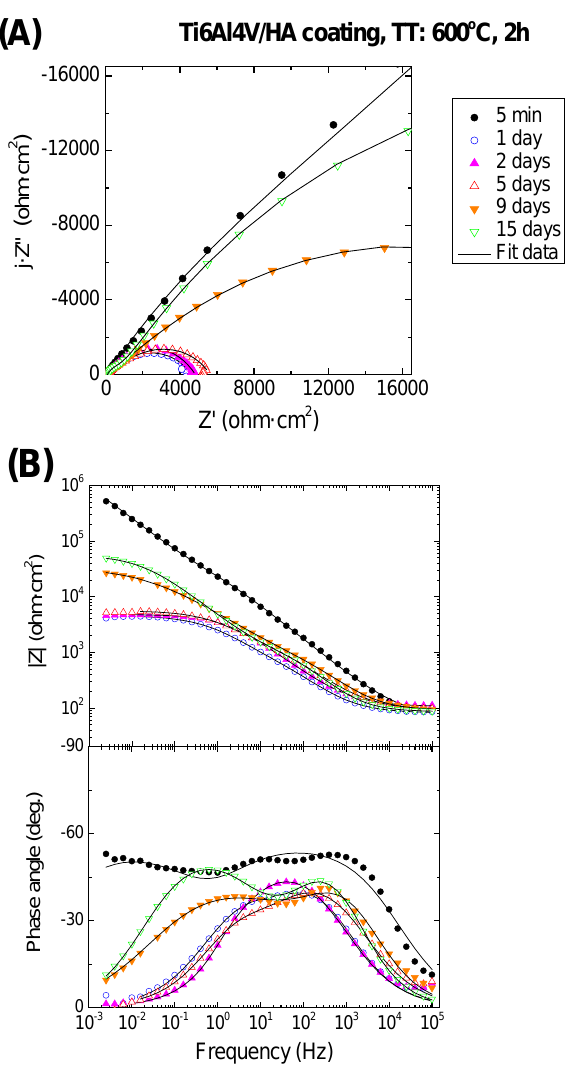
Figure 14. Evolution of the electrochemical impedance spectra with immersion time in SBF for a HAp-coatings/Ti6Al4V system thermally treated at 600 °C, 2 h. Materials 2017 , 10 , 94